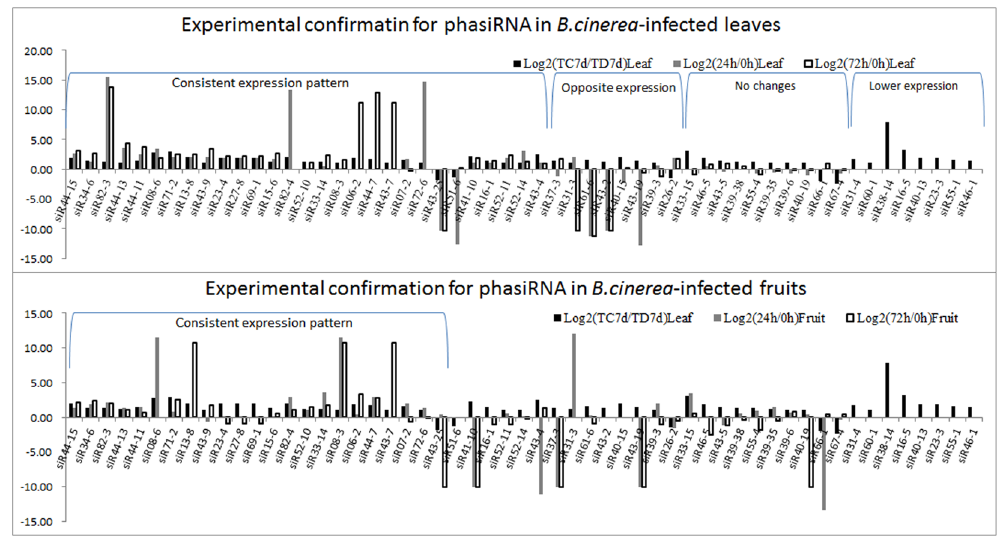
Figure 4. Experimental confirmation for B.cinerea -responsive phasiRNAs in tomato leaves ( A ) and fruits ( B ).